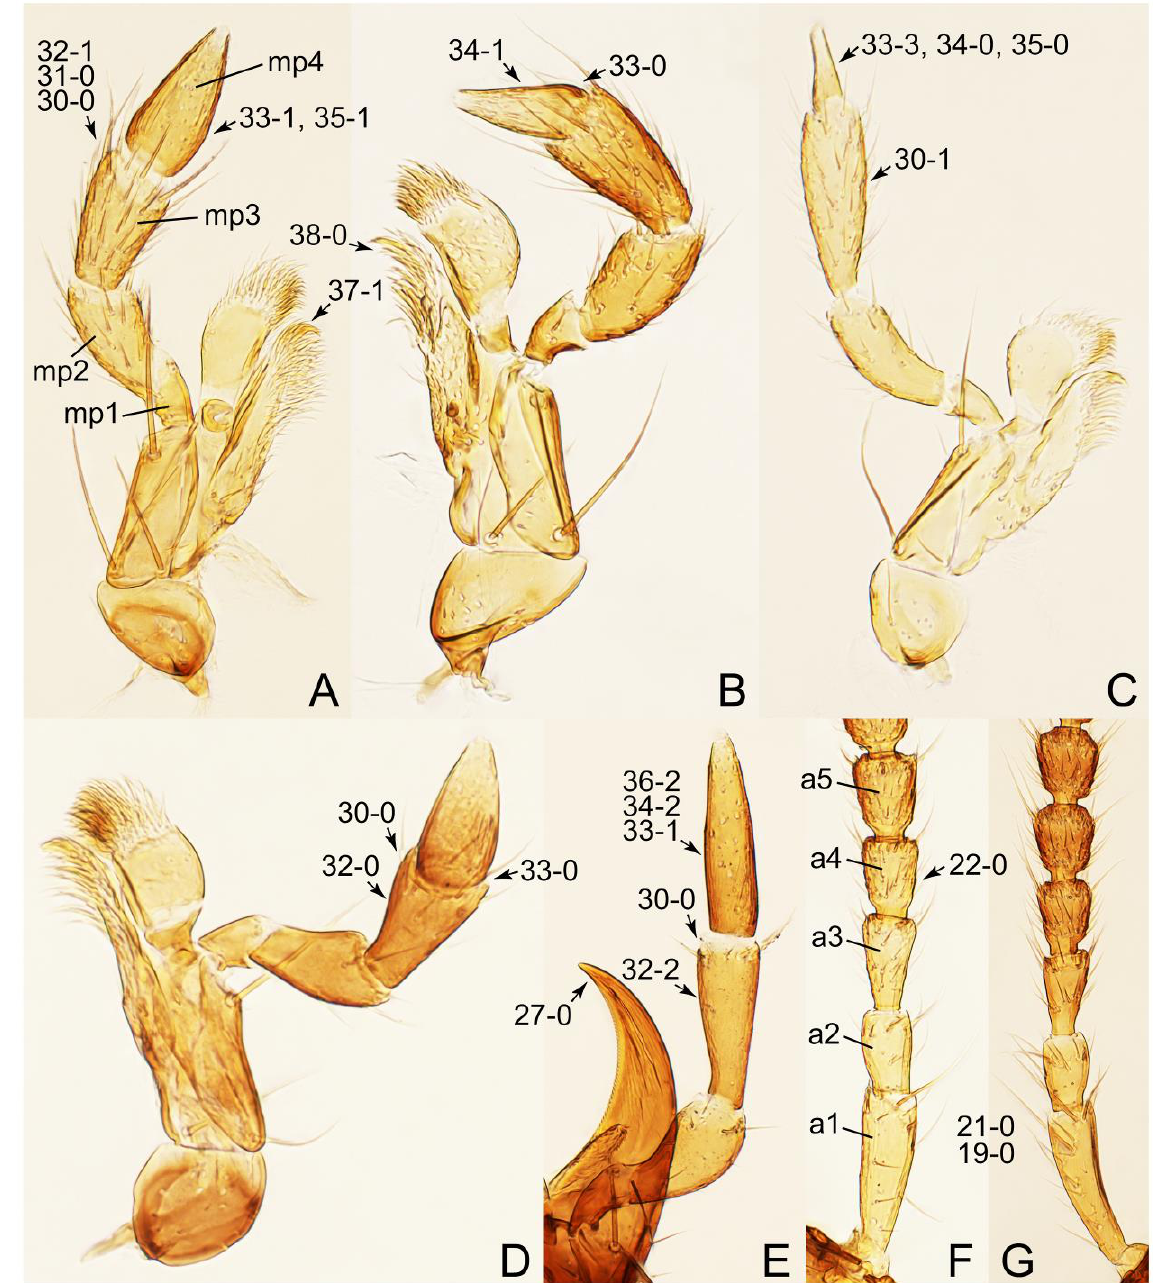
Figure 68. Photographs of body parts of Mycetoporinae, enlarged. ( A ) right maxilla of Bolitobius castaneus , ventral view. ( B ) right maxilla of Bryoporus cf. orientalis , dorsal view. ( C ) right maxilla of Mycetoporus punctus , ventral view. ( D ) left maxilla of Lordithon thoracicus thoracicus , ventral view. ( E ) left maxillary palpus and left mandible of Bobitobus lunulatus , ventral view. ( F ) basal half of left antenna of Mycetoporus punctus , dorsal view. ( G ) basal half of right antenna of Bryoporus cf. orientalis , ventral view. Abbreviations: a1–5, antennomere 1–5; mp1–4, maxillary palpomere 1–4. Characters and character states (format X-X) are indicated on each